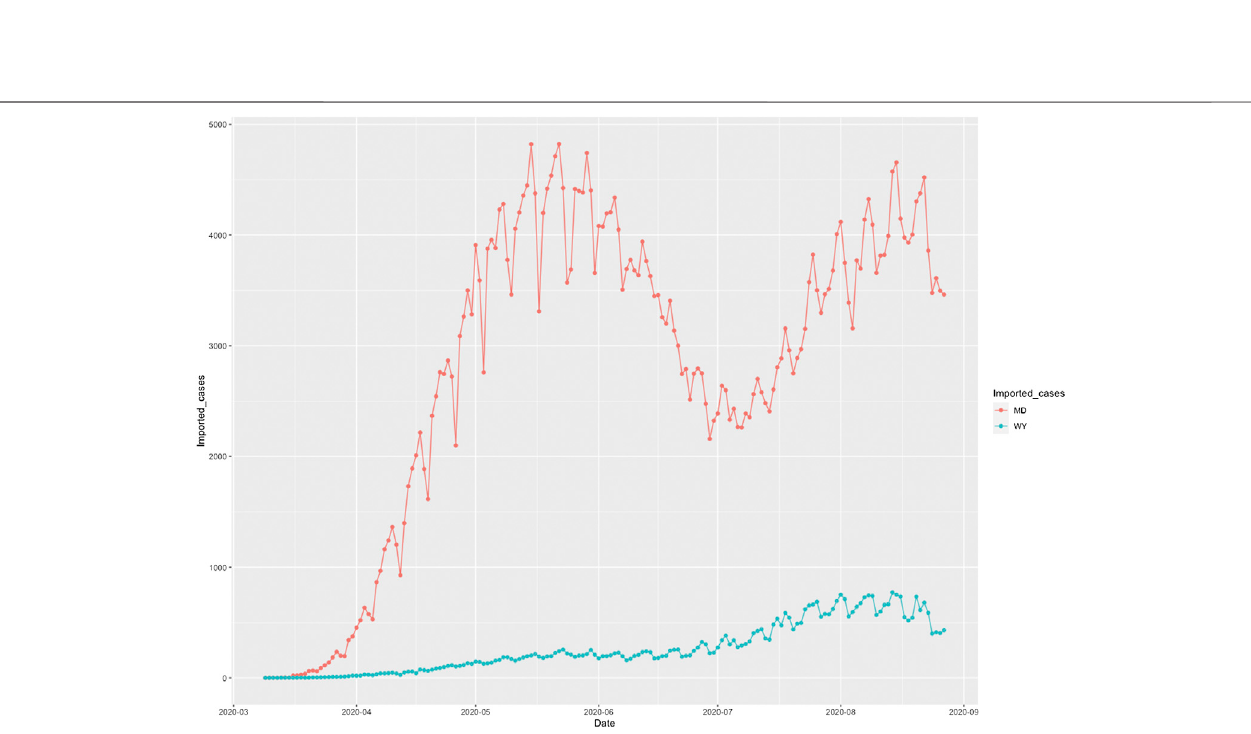
FIGURE 2 | Number of imported COVID-19 cases as a function of time from March 5, 2020 to August 25, 2020 in Maryland (MD) (red color) and Wyoming (WY) (blue color).